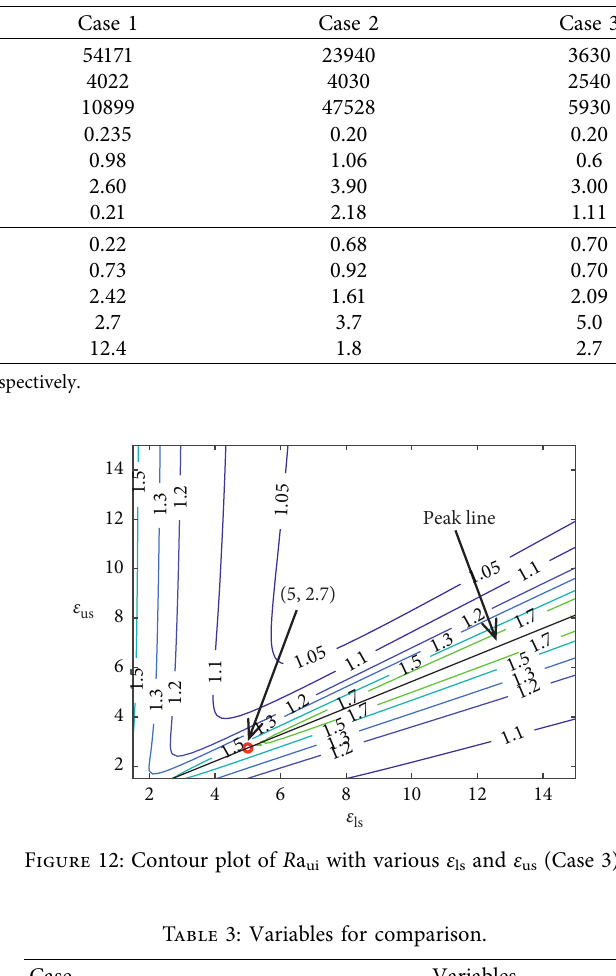
Table 2: Related parameters for the three cases.